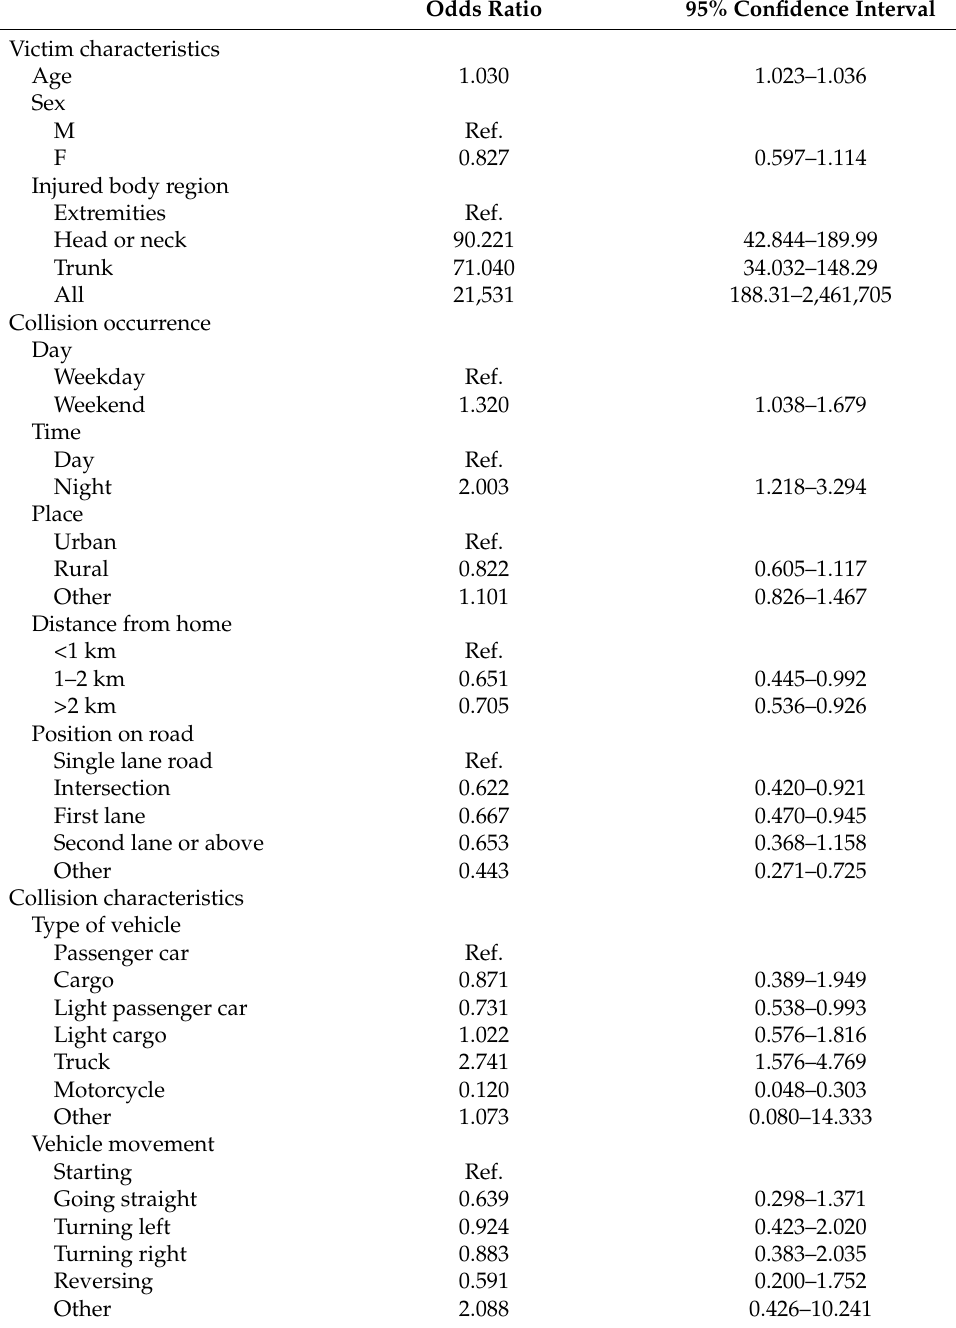
Table 2. Odds ratios and 95% confidence intervals for factors that affected fatal injuries. Odds Ratio 95% Confidence